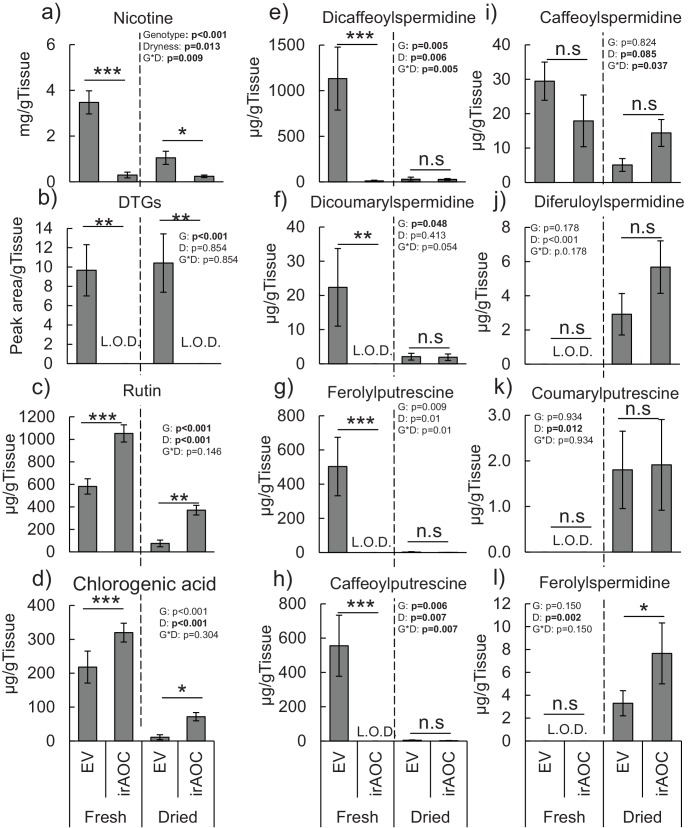
Secondary metabolite profiles in the leaves of N. attenuata before and after drying.Mean concentrations (±SE) of nicotine (a), diterpeneglycosides (DTGs) (b), rutin (c), chlorogenic acid (d) dicaffeoylspermidine (e), dicoumarylspermidine (f), ferolylputrescine (g), caffeoylputrescine (h), caffeoylspermidine (i), diferuloylspermidine (j), coumarylputrescine (k) and ferolylspermidine (l) (n = 5). Asterisks indicate significant differences between genotypes within water content status (*p<0.05; **p<0.01; ***p<0.001). N. S: not significant. L.O.D: limit of detection.